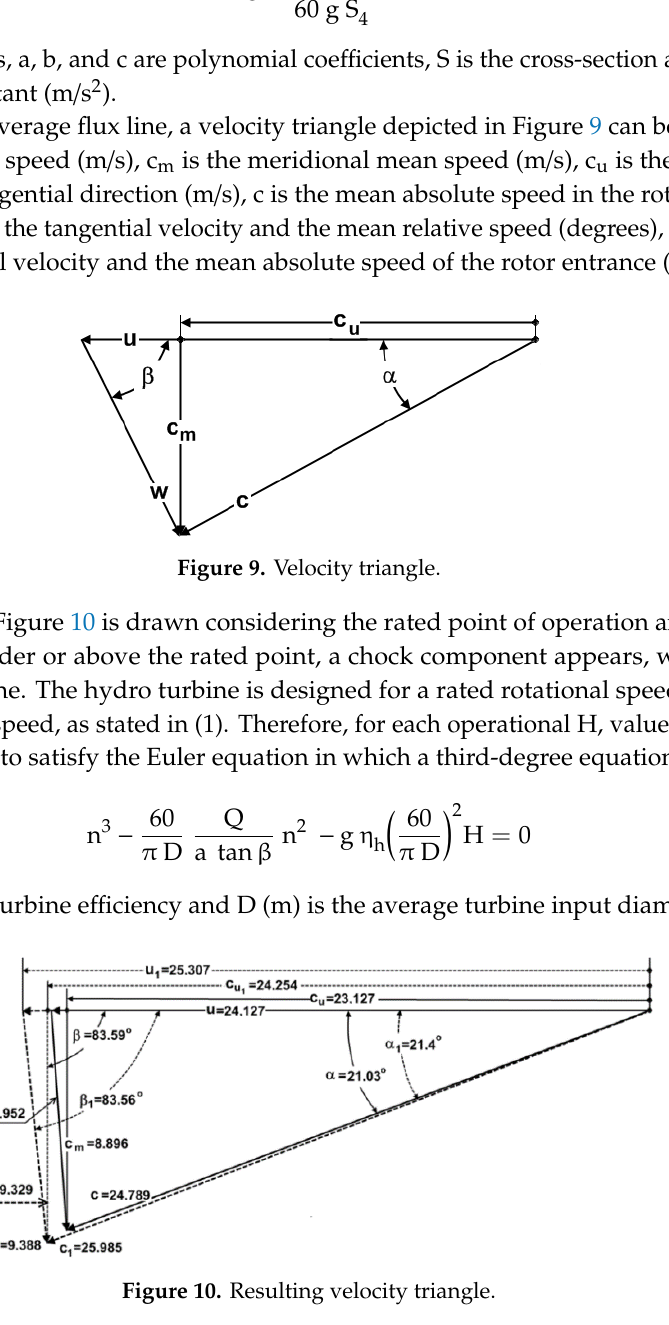
Figure 10. Resulting velocity triangle.